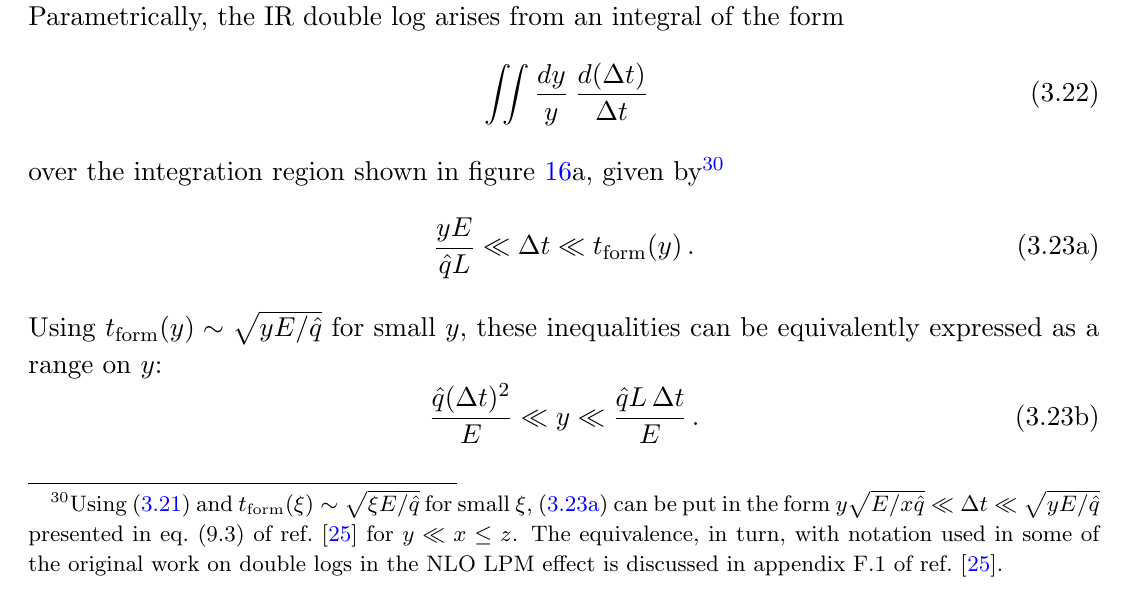
(cid:28) 0 used in earlier literature, and (c) the IR regulator y (cid:24)